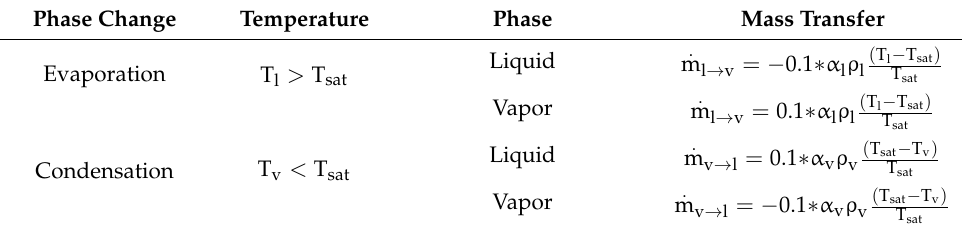
Table 2. Mass transfer model by Lee